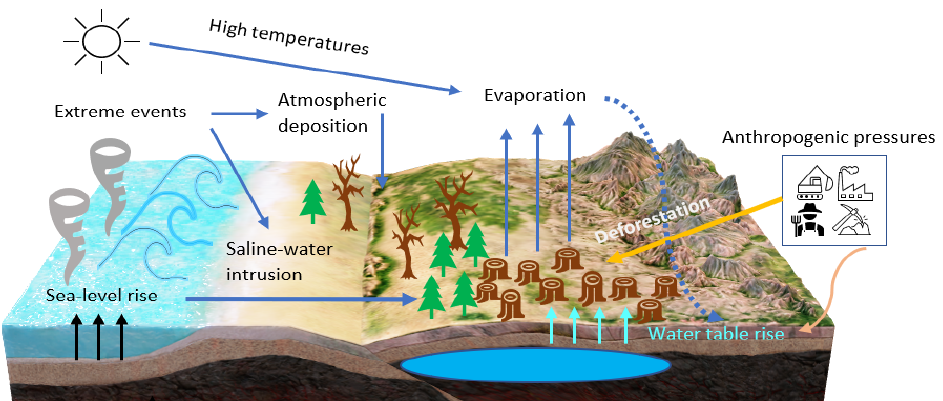
Figure 1. Current processes leading to salinization. Sea-level rise and extreme events promote seawater flooding and intrusion into coastal land which leads to deforestation. Deforestation can result in increased rates of evaporation which brings salt to the surface layers of the soil and catalyse deforestation and soil fertility reduction. Human practices can induce salinization through deforestation, effluent discharge and water-table rise which may bring salts to the top layers of the soil. High temperatures lead to increased evaporation and other extreme events can cause atmospheric deposition of salts.